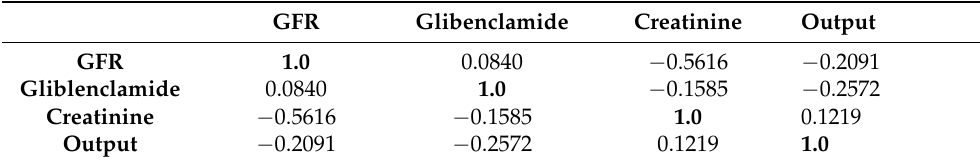
Table 6. Correlation Matrix.